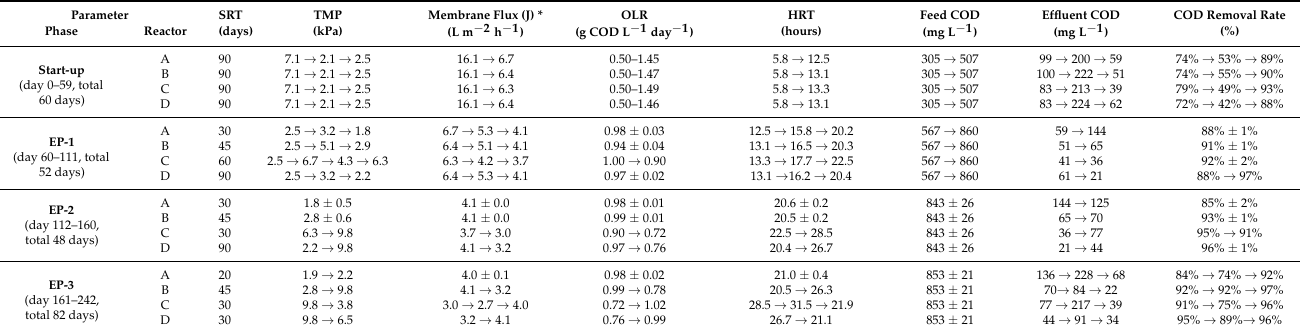
( → ) Variable trend: initial → middle → final; ( ± ) Stable performance: One standard deviation to show spread of data from the average value under stable performance; (*) Daily